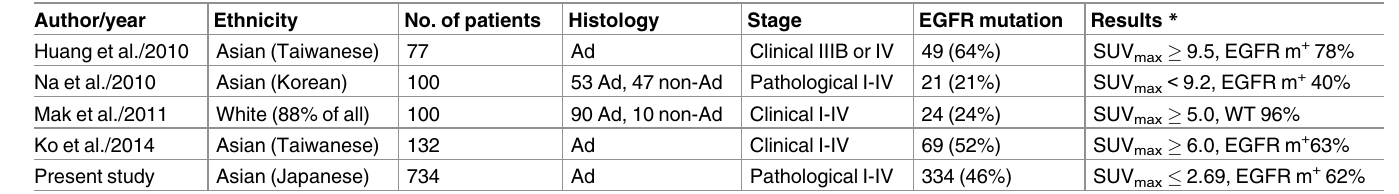
Table 5. Clinical studies of the role of 18 F-FDG uptake on PET-CT scans in predicting EGFR mutation